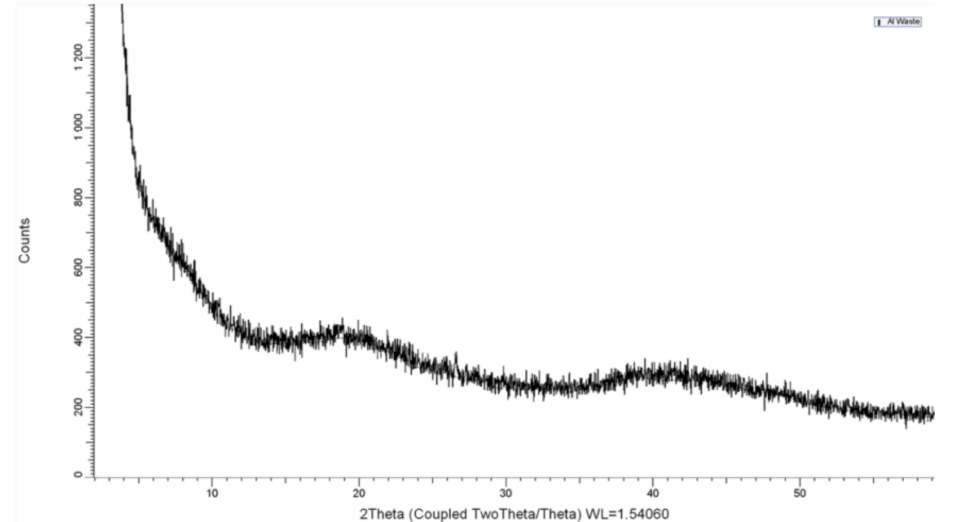
Figure A1. XRD pattern of the amorphous aluminium hydroxide